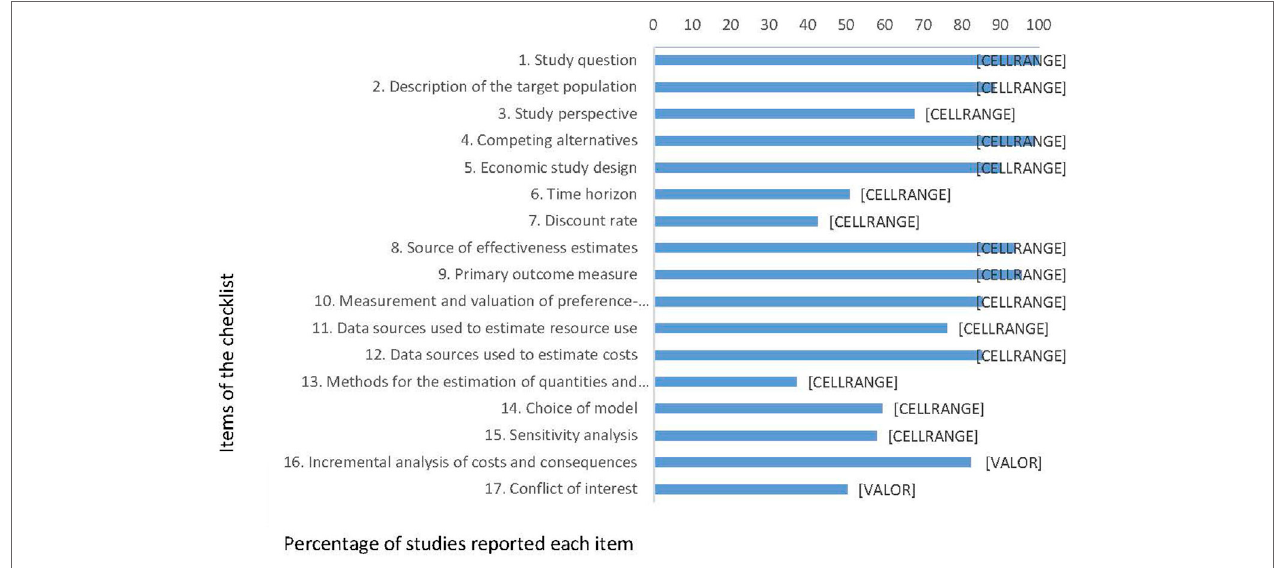
FiGURe 5 | Percentage of studies complying with recommendations for reporting of full health economic evaluation ( n = 197), Brazil, 1980–2013.